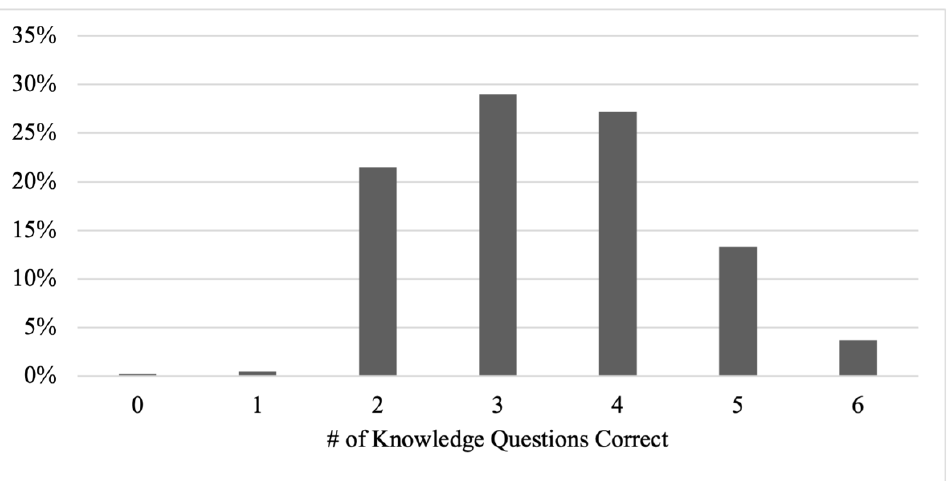
Figure 2. Frequency of Correct Selections in Knowledge Quiz.